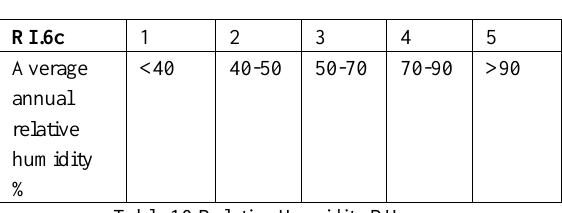
Table 10.Relative Humidity RH